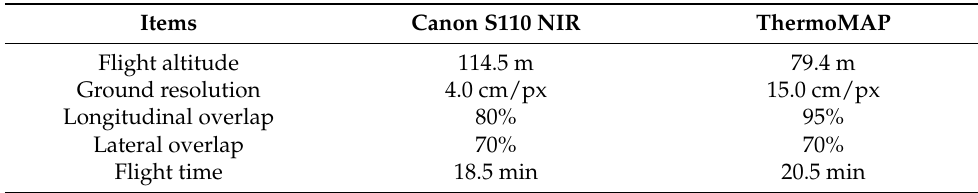
Table 2. Specifications of multispectral and thermal infrared